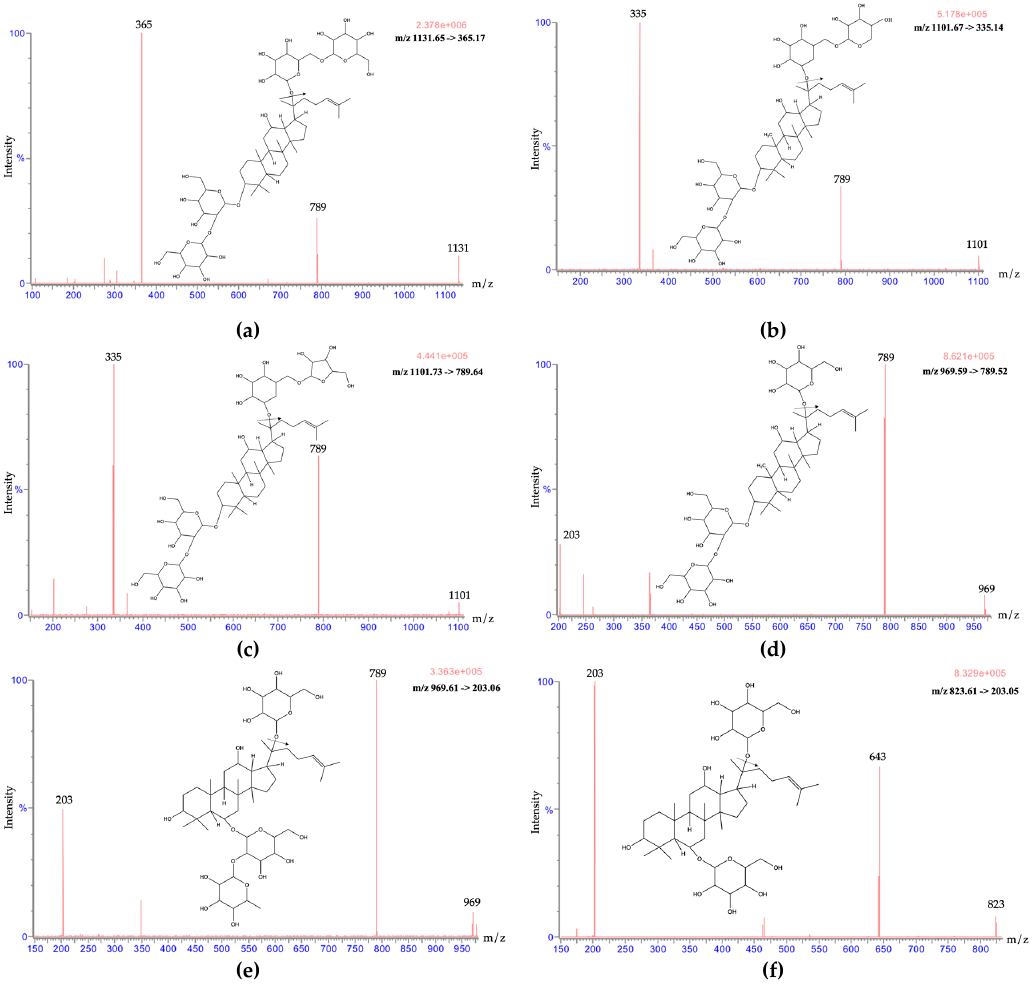
Figure 2. Product ion mass spectra of six marker compounds: ( a ) ginsenoside Rb 1 , ( b ) ginsenoside Rb 2 , ( c ) ginsenoside Rc, ( d ) ginsenoside Rd, ( e ) ginsenoside Re, and ( f ) ginsenoside Rg 1 .